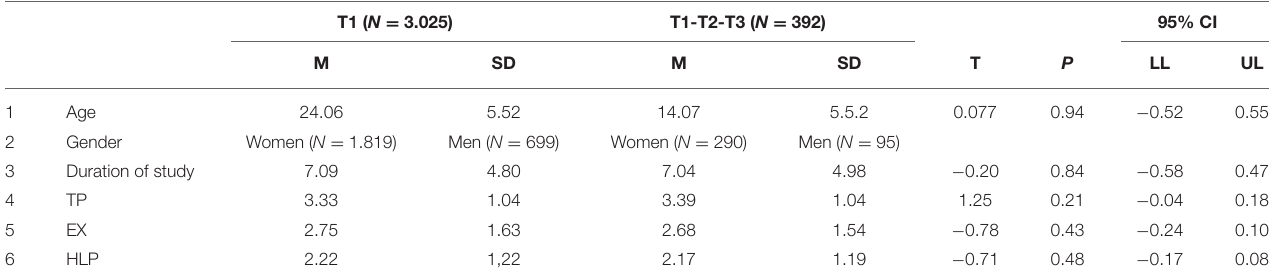
TABLE 1 | Means, standard deviations, and differences in age, gender, duration of study, time pressure, exhaustion and health-related loss of productivity between cross-sectional and longitudinal participants at T1.